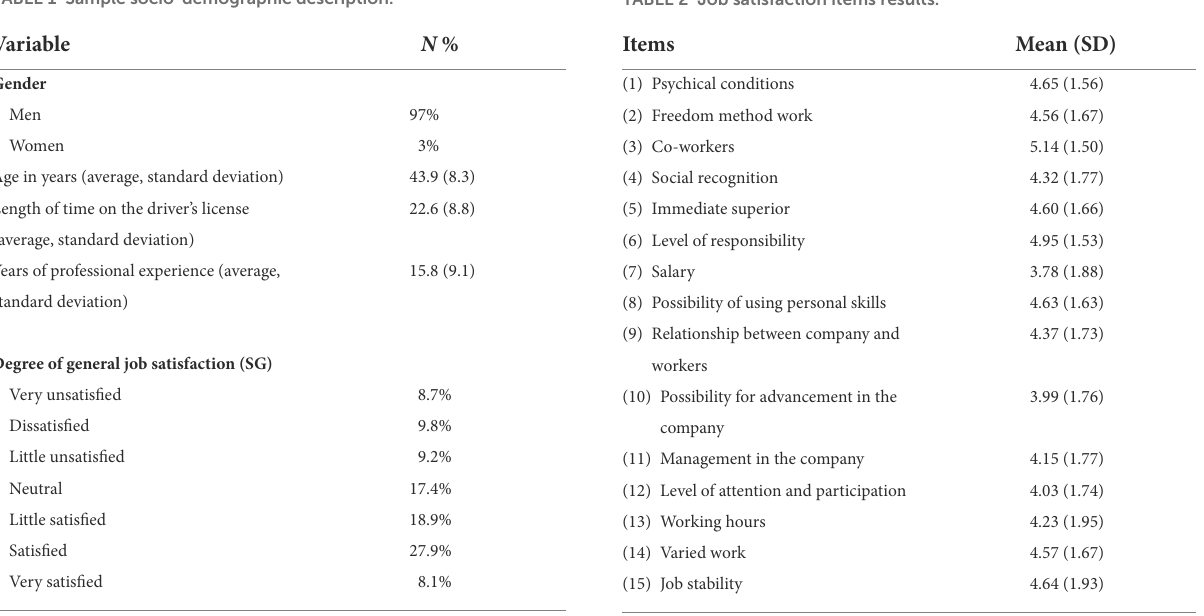
TABLE 2 Job satisfaction items results. TABLE 1 Sample socio-demographic